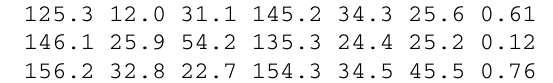
FIGURE 1 | Connectivity data can be described as connexels, six-dimensional pairs of three-dimensional spatial positions, and an associated connection strength. As in this example of functional connectivity, such data can be represented with the node positions of a cortical surface ( Top left ), and a matrix of connection strengths ( Top right ). Connexels can be visualized with straight lines connecting each pair of connected nodes, but the structure of the data is unclear when a large number of connexels are included ( Bottom